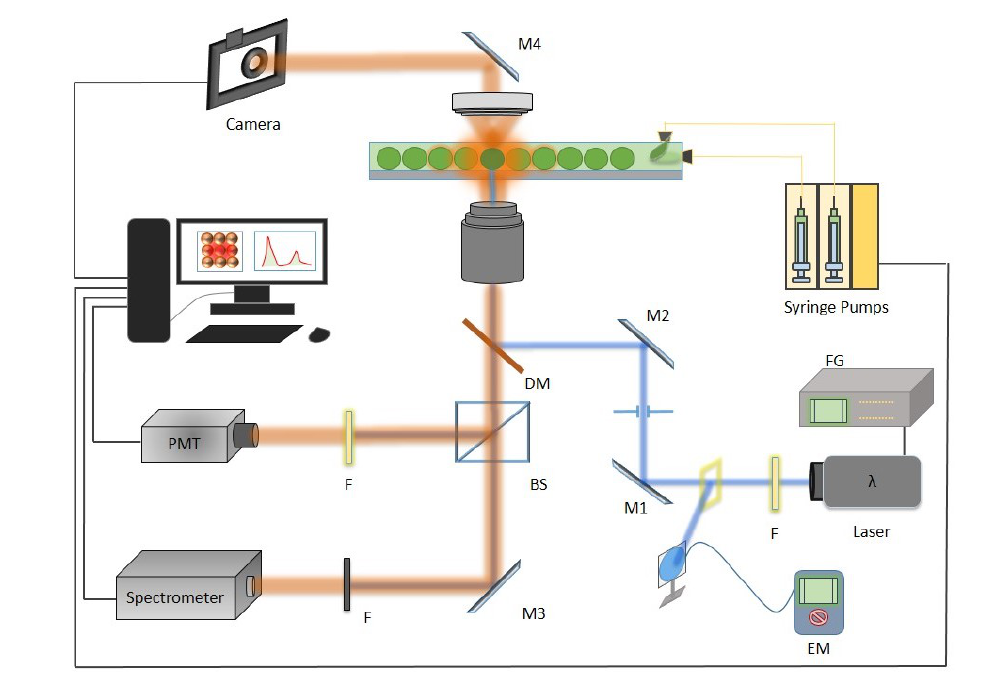
Figure 3. The setup containing the droplet generation assembly, optics and detection unit. On the optical path, the ps-pulsed source (355 nm), F (filter), M1 and M2 mirrors for step-up, dichoric mirror (DM) (506 nm), camera with notch filter, BS (beam splitter) to reflect the acquired signal to detector (setup adapted from